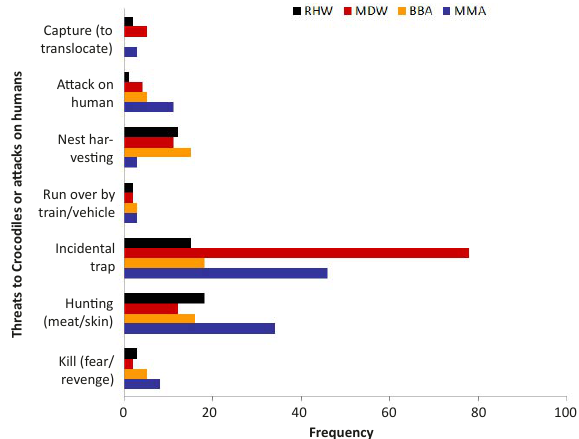
Figure 3. Recorded incidence of threats to Saltwater Crocodiles and attacks on humans in crocodile vigilance zones during 2008–2012